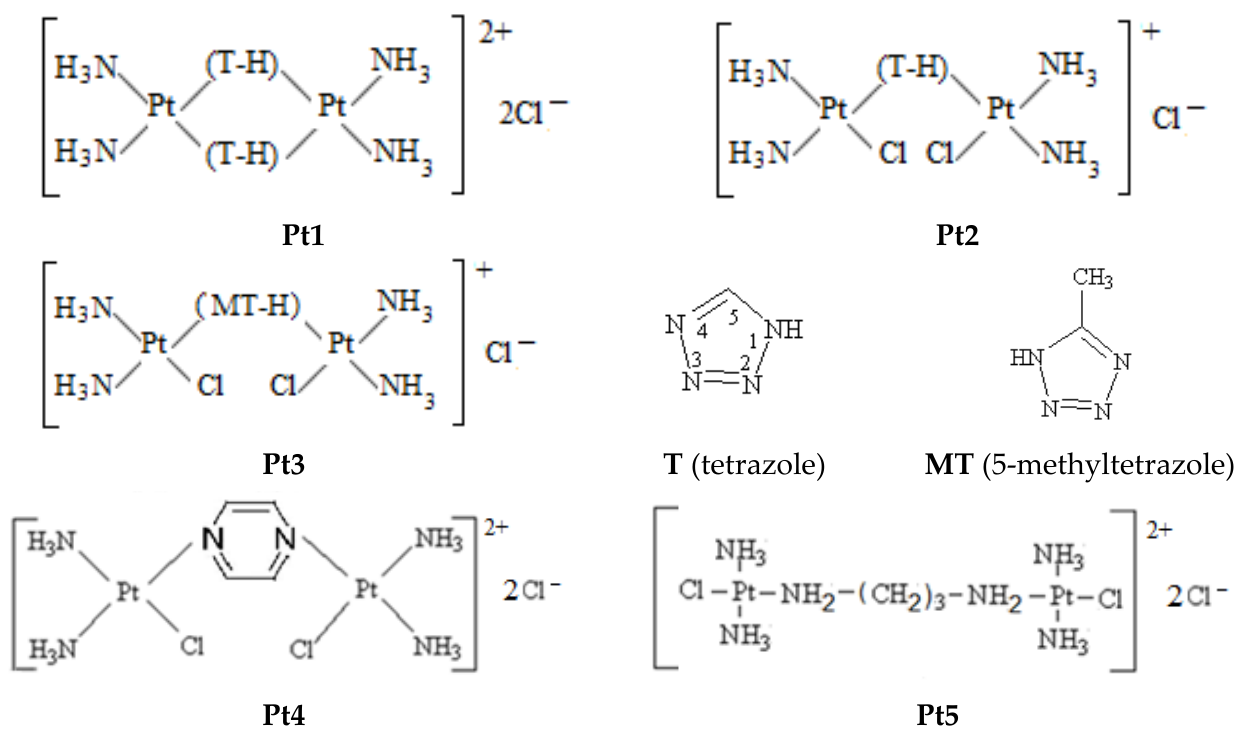
Figure 1. The structure of binuclear platinum compounds.